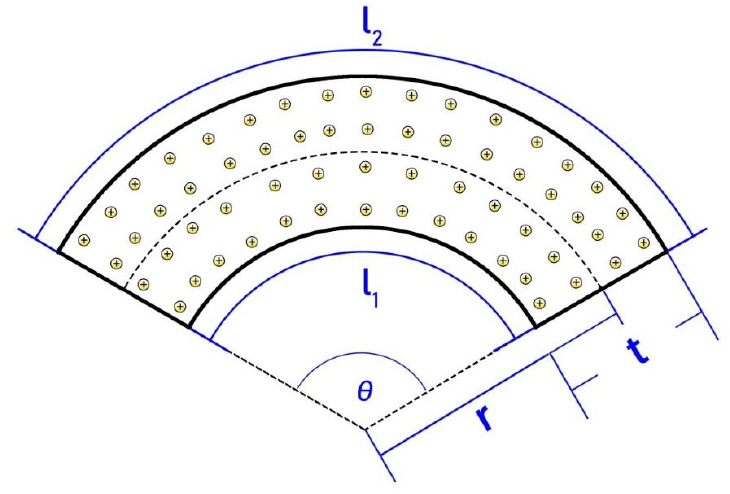
Figure 9. IPMC in the bending state.